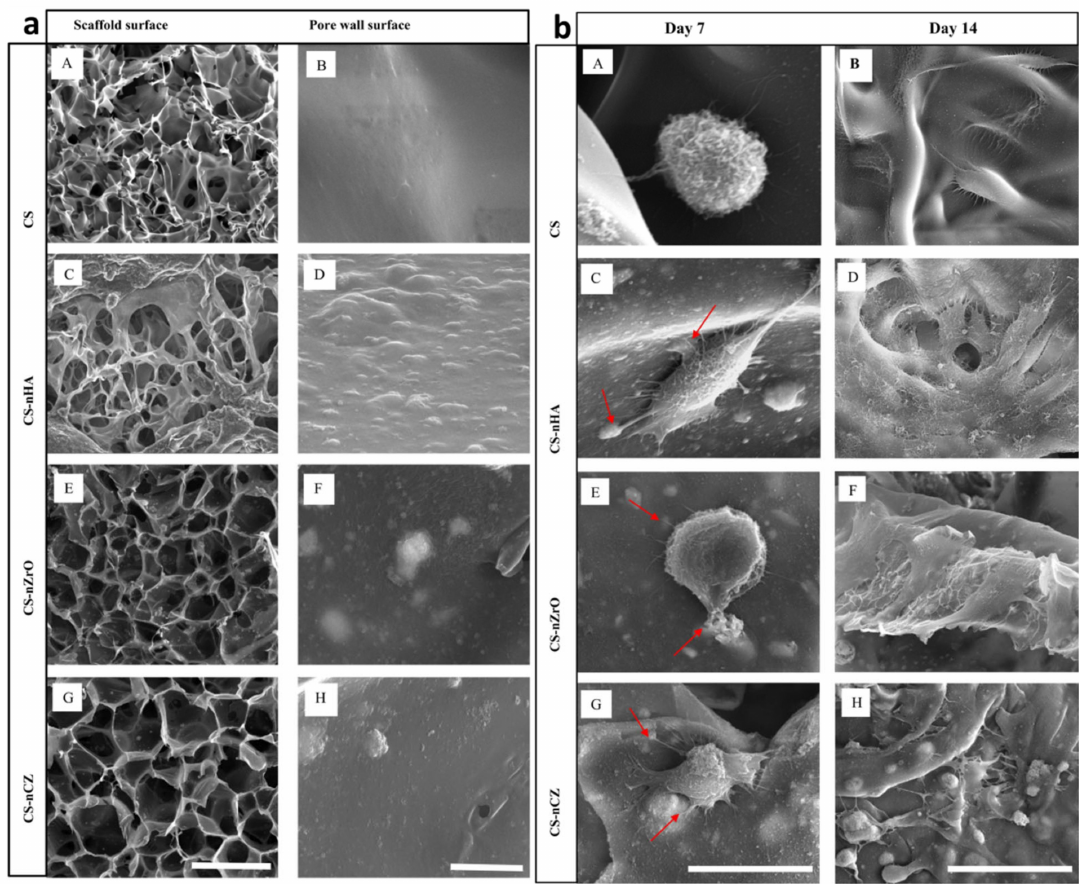
Figure 4. ( a ) SEM images showing the highly porous morphology of the scaffold surface ( A , C , E , G ) and magnified images showing the surface of the scaffold wall ( B , D , F , H ); the scale bars indicate 100 and 2 µ m for the scaffold surface and the pore wall surface, respectively. ( b ) SEM images ( A – H ) showing the morphology of pre-osteoblast attached and proliferating along the surfaces of different scaffolds; the scale bars indicate 20 and 50 µ m in the images taken on days 7 and 14, respectively. Images used from Gaihre et al. [62] reprinted with permission from Elsevier, copyright©